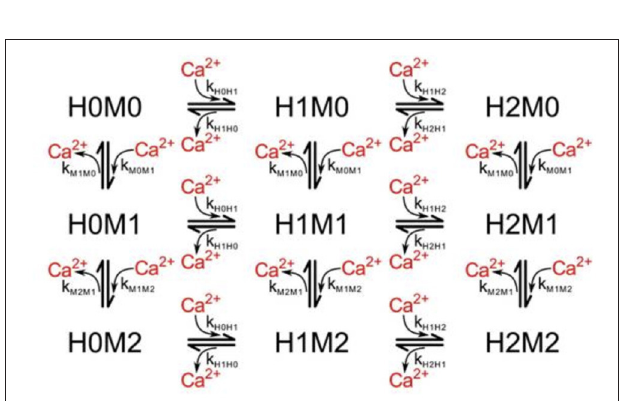
FIGURE 3 | State diagram for calbindin binding where H a M b describes the a th high-affinity binding state and the b th medium-affinity binding state. Reproduced with permission from Bartol et al.